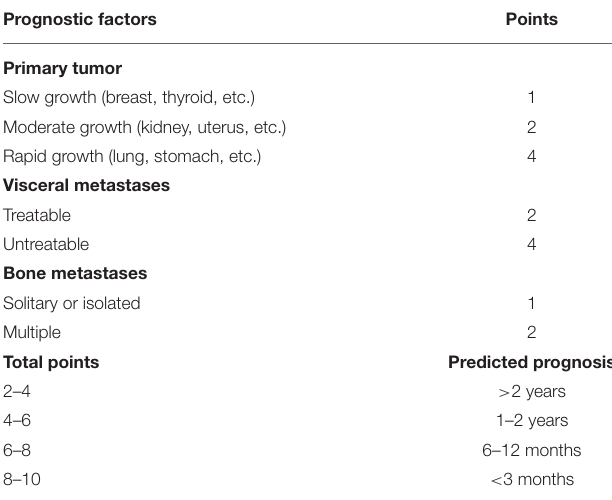
TABLE 3 | Tomita scoring system. Prognostic factors